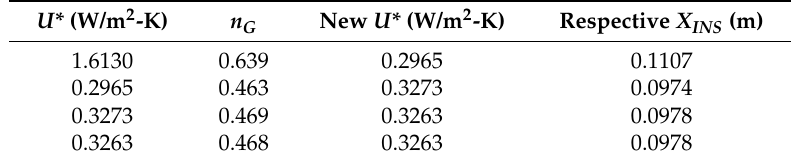
Table 7. Application of successive substitutions to find optimum thermal transmittance U*